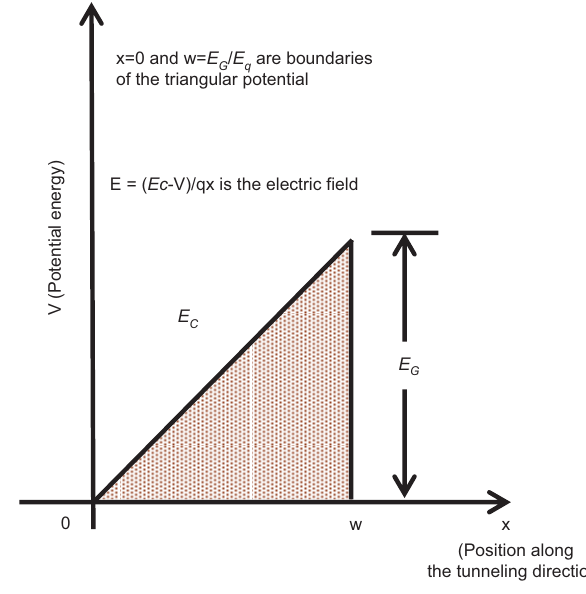
Figure 4 Band-to-band tunneling can be calculated by approximat- ing the tunneling barrier as a triangular potential, where carriers should tunnel through the base of the